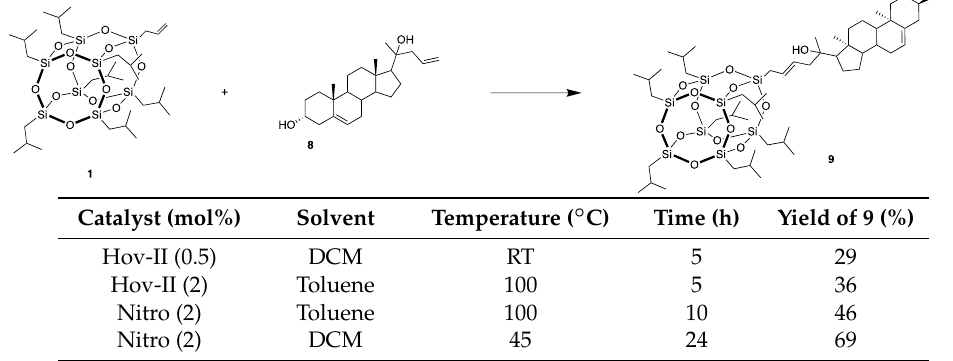
Table 3. Cross metathesis of allyl-POSS 1 with derivative of pregnenolone 8 .